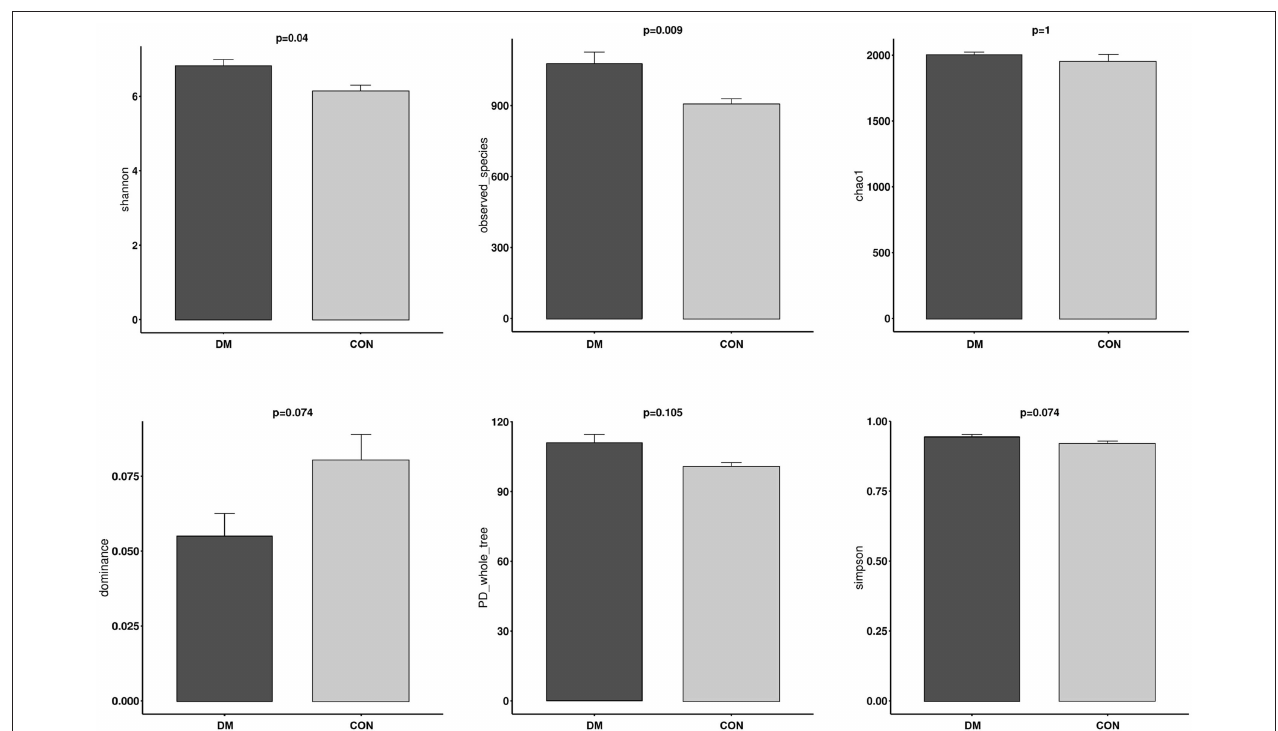
FIGURE 2 | Alpha Diversity of conjunctival microbiota between DM patients and healthy subjects.